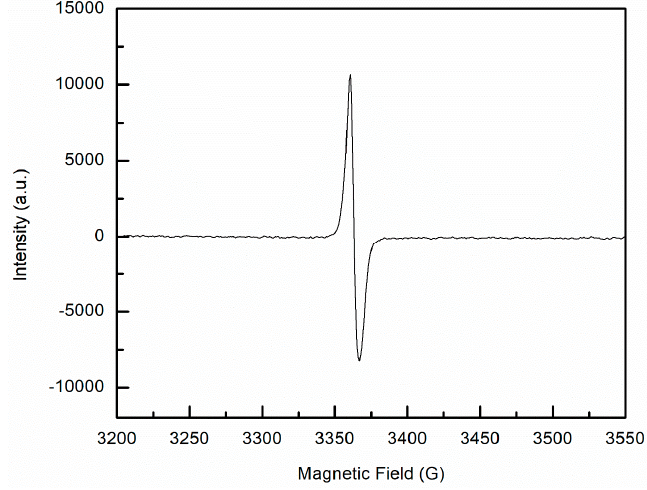
Figure 10. EPR spectrum of present polyenyl free radicals in 50 kGy gamma irradiated UHMMPE fibers six years post irradiation.